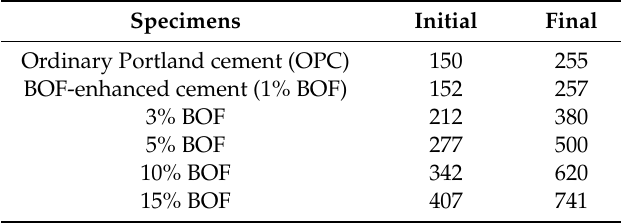
Table 3. Initial and final setting times for OPC and BOF-enhanced cement mortars (all in